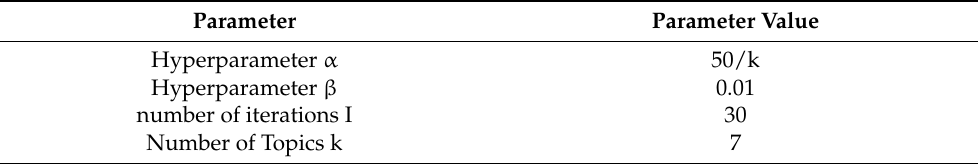
Table 2. LDA topic model parameter